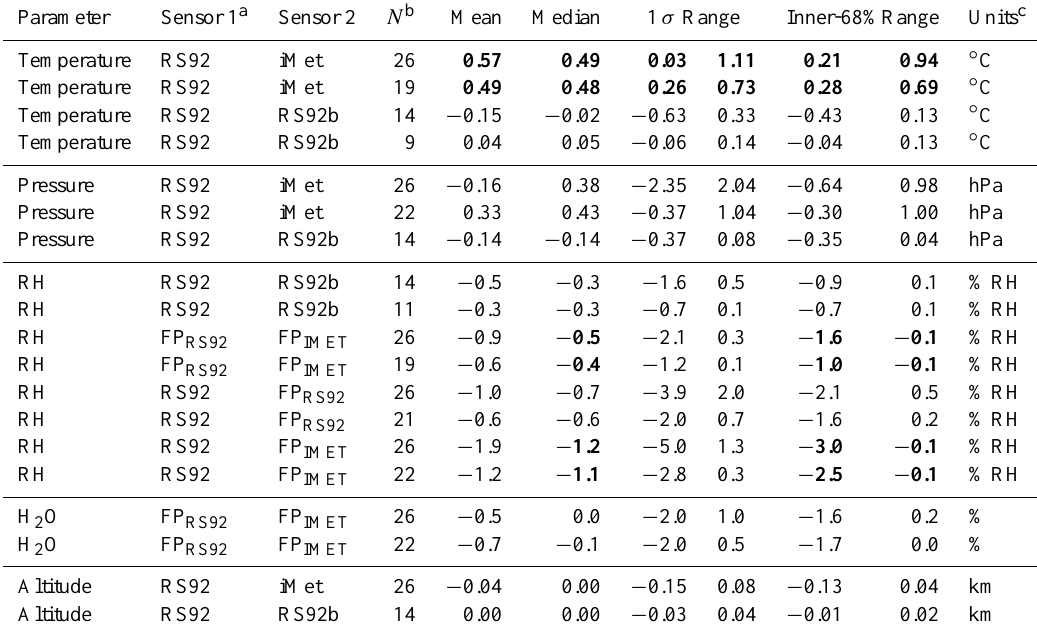
Table 3. Measurement difference